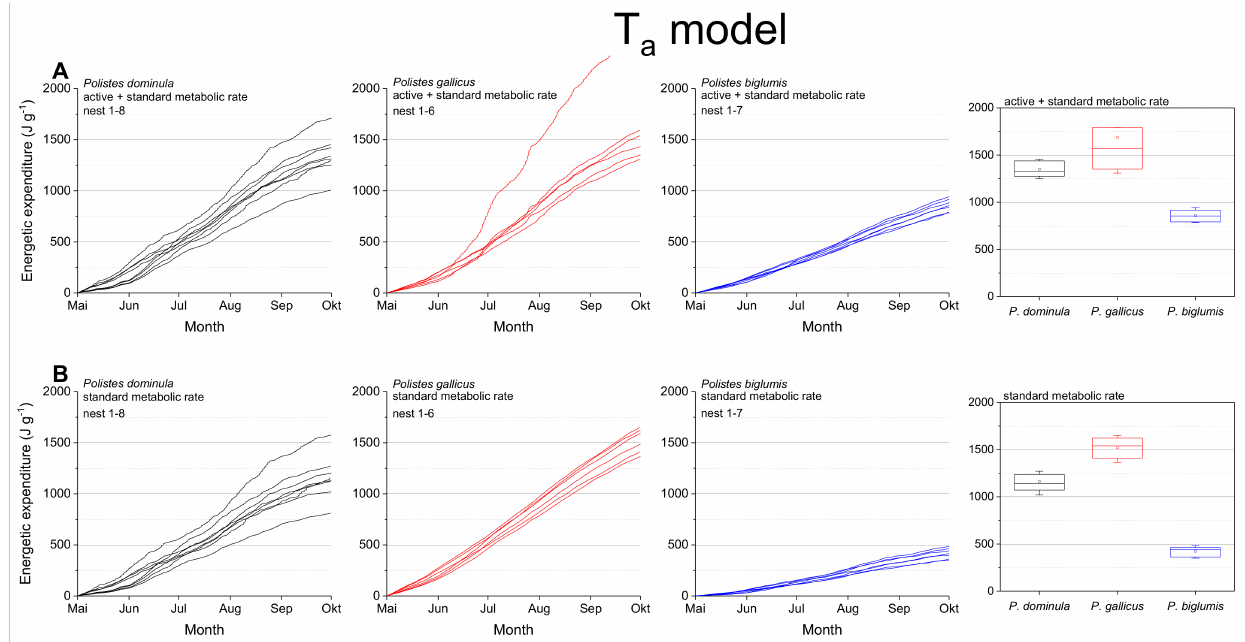
Figure 3. T a model: Mass specific energetic expenditure of paper wasps during a breading season, calculated from ambient air temperature at the nest (T a ) and metabolic rate-temperature models [17,29]. ( A ) Mixed activity (MMR, mean of active and standard metabolic rate), and ( B ) resting wasps (SMR, standard metabolic rate). Box and whisker plots represent median costs with first and third quartiles summed for the breeding season (May–October); dots in plots are means.